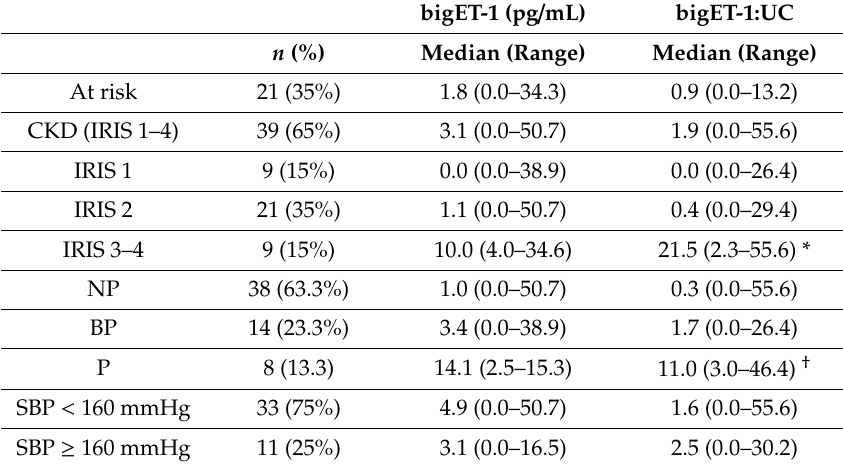
Table 4. Urinary big endothelin-1 concentrations (bigET-1) and urinary big endothelin-1 to urinary creatinine ratio (bigET-1:UC) in samples of cats classified in the di ff erent stages and substages of the International Renal Interest Society (IRIS) classification. Samples collected at the time of inclusion and at the di ff erent checkpoints were included. Number and percentage (in brackets) of cases included in each group are also reported. bigET-1 (pg / mL)